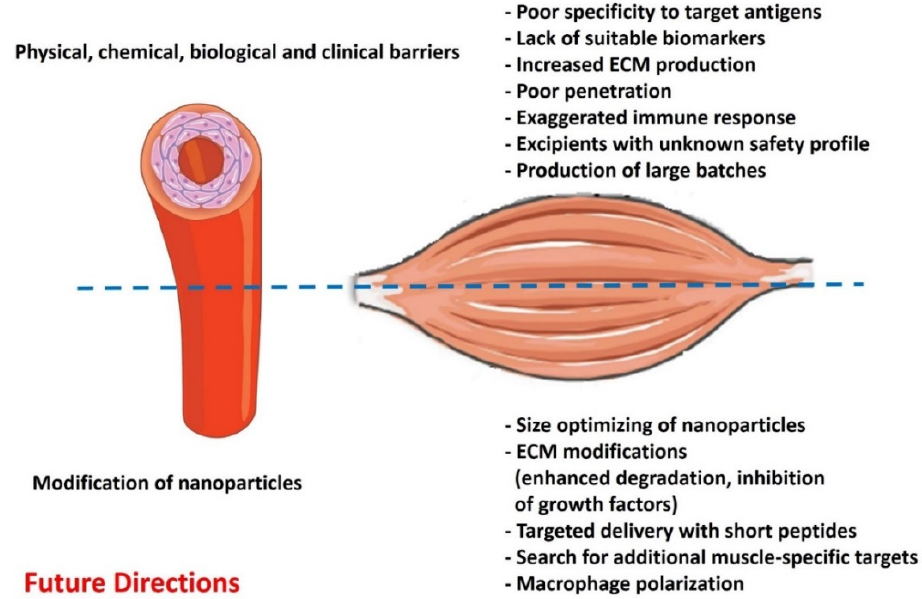
Figure 3. Potential limitations and future directions for using nanomedicine in treating muscular dystrophies.